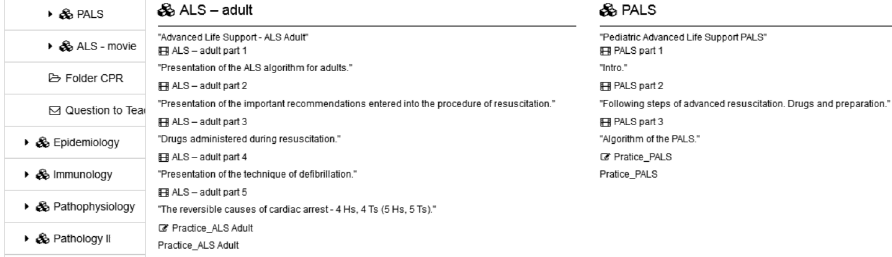
Figure 2. Lectures available to students as e-learning materials (ALS-adult, PALS = pediatric ALS)